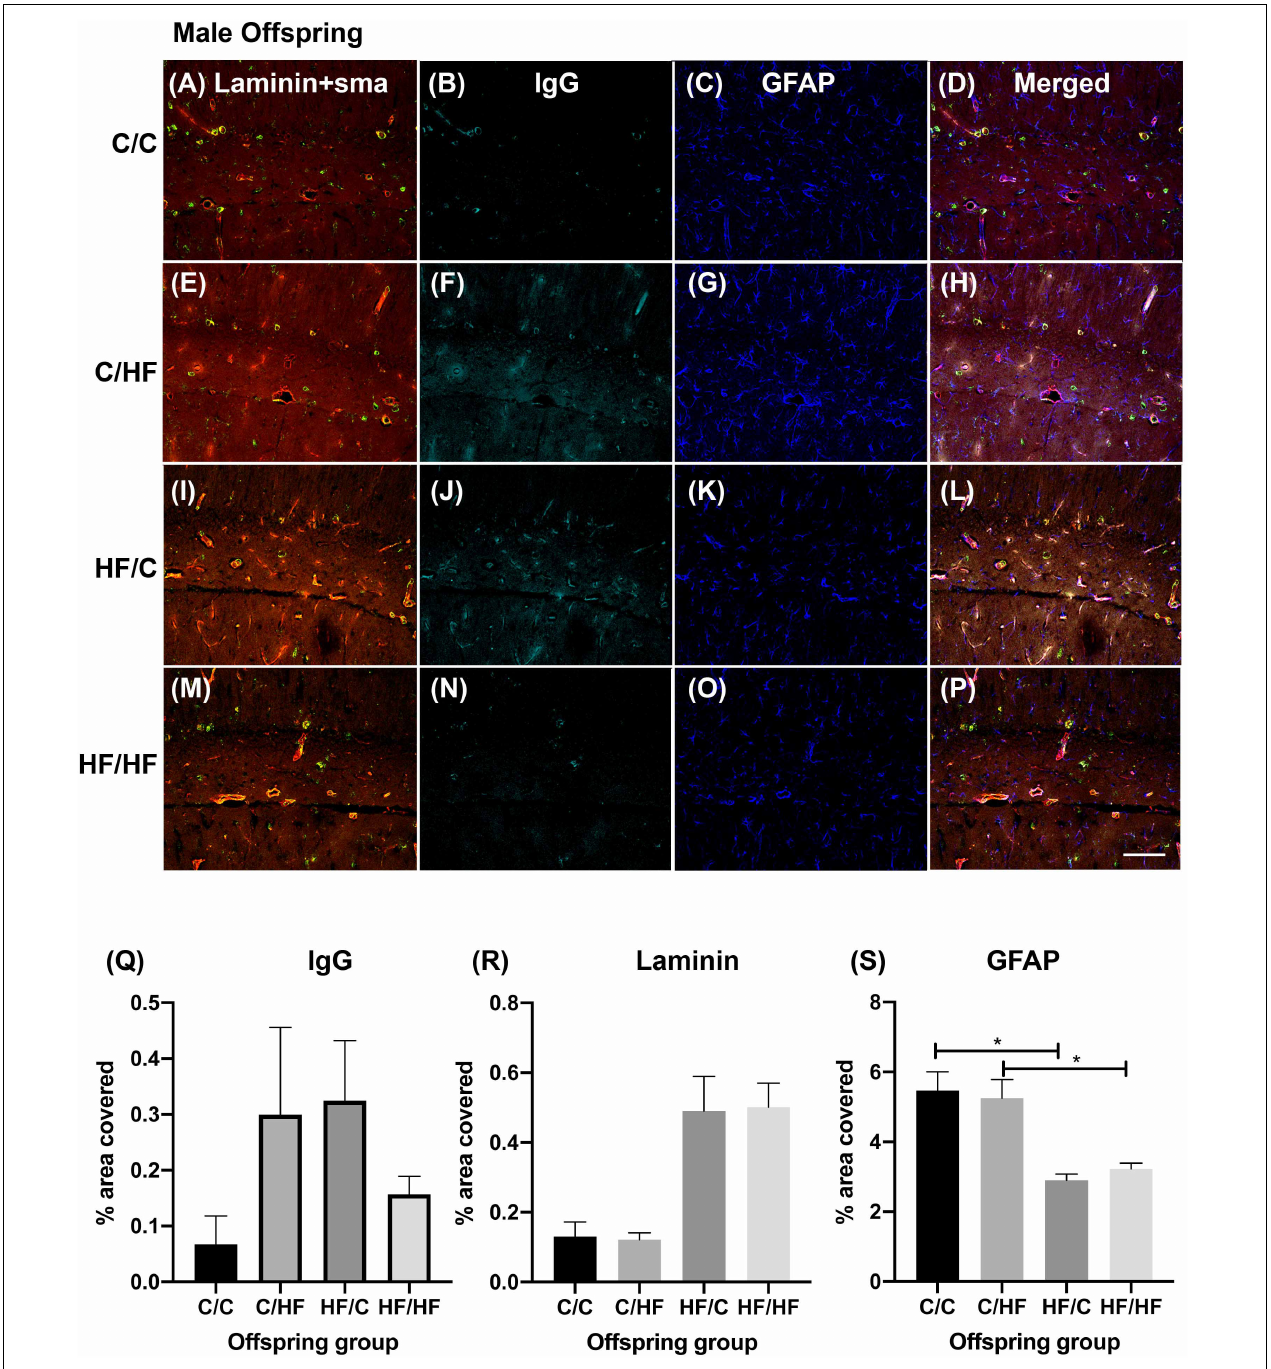
FIGURE 3 | Effect of pre- and post-natal high fat diet on hippocampal blood–brain barrier integrity in male offspring. (A–P) Photomicrographs of hippocampal tissue sections stained for laminin (red, A,E,I,M ), smooth muscle actin (green, A,E,I,M ), IgG (turquoise, B,F,J,N ) and GFAP (blue, C,G,K,O ) in 16-month old male C/C (A–D) , C/HF (E–H) , HF/C (I–L) and HF/HF mice (M–P) . (Q–S) Quantification of hippocampal area positive for IgG extravasation (Q) , laminin (R) and GFAP (S) . Data represent mean ± SEM. ∗ p < 0.05, two-way ANOVA with Holm–Sidak post hoc test. Scale bar = 100 µ m.